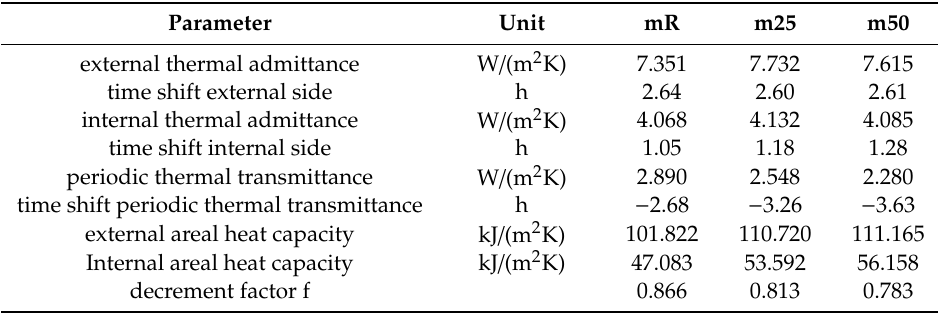
Table 6. Calculation results according to EN ISO